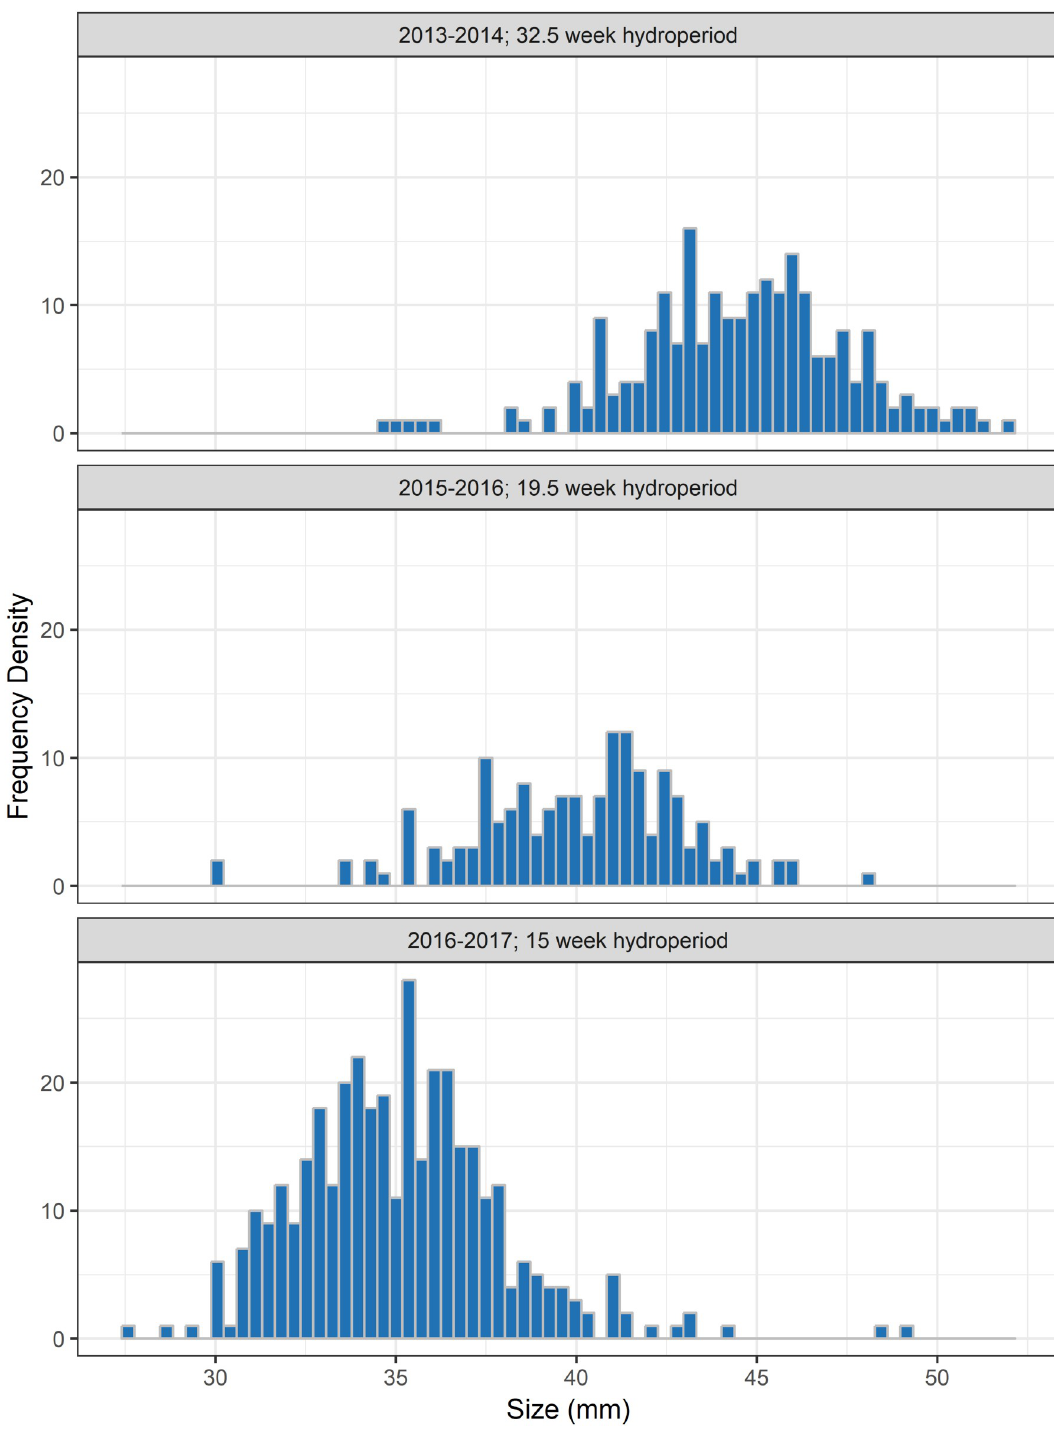
Fig 2. Metamorph size distribution. Size distribution of reticulated flatwoods salamander metamorphs captured emigrating from two drift-fenced wetlands on Eglin Air Force Base, Florida, for a subset of years with differing hydroperiods. The year and corresponding hydroperiod for the wetlands that produced these cohorts are displayed above each